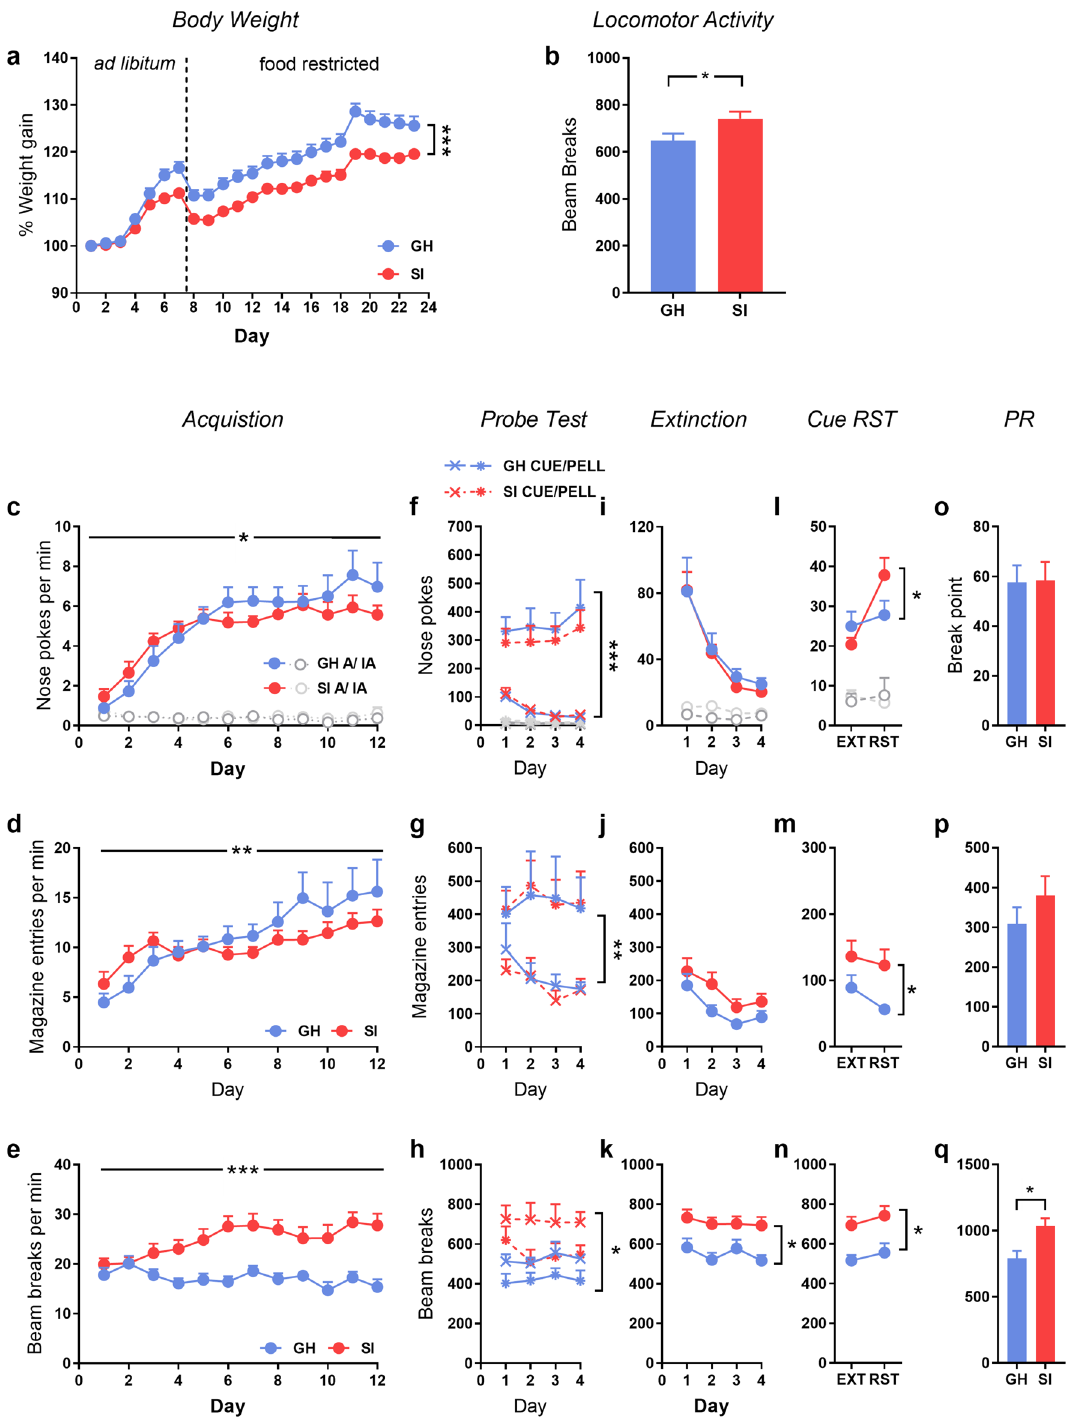
Figure 2. Experiment 1: The effect of social isolation on the acquisition and reinstatement of responding for a sucrose pellet. ( a ) Percentage weight gain across the entire study, including when food was freely available (ad libitum) and following restriction prior to operant training (food restricted). ( b ) Spontaneous locomotor activity during habituation to the instrumental chambers. Active (colour) and inactive (grey) nose-pokes, magazine entries and locomotor activity across acquisition ( c – e ), the probe test trial ( f–h ), extinction training ( i – k ), cue-reinstatement ( l–n ) and the progressive ratio (PR) test of motivation for the food reward ( o – q ). GH group housed, SI socially isolated. Asterisks indicate main effect or interaction involving housing condition where * p < 0.05, ** p < 0.01 or *** p < 0.001. n = 16/group except 8/group for the probe